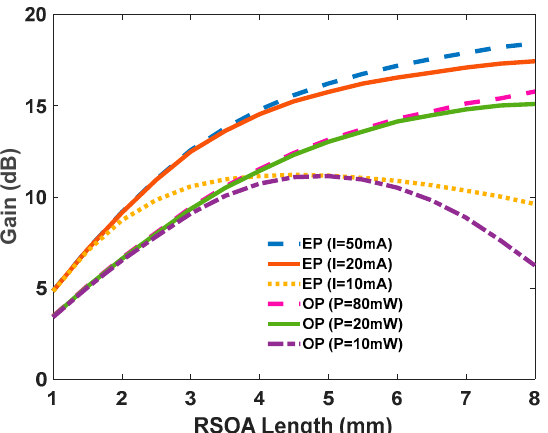
Figure 3. Optical gain of OP and EP QD-RSOAs versus the RSOA’s length for various pump powers and current densities.